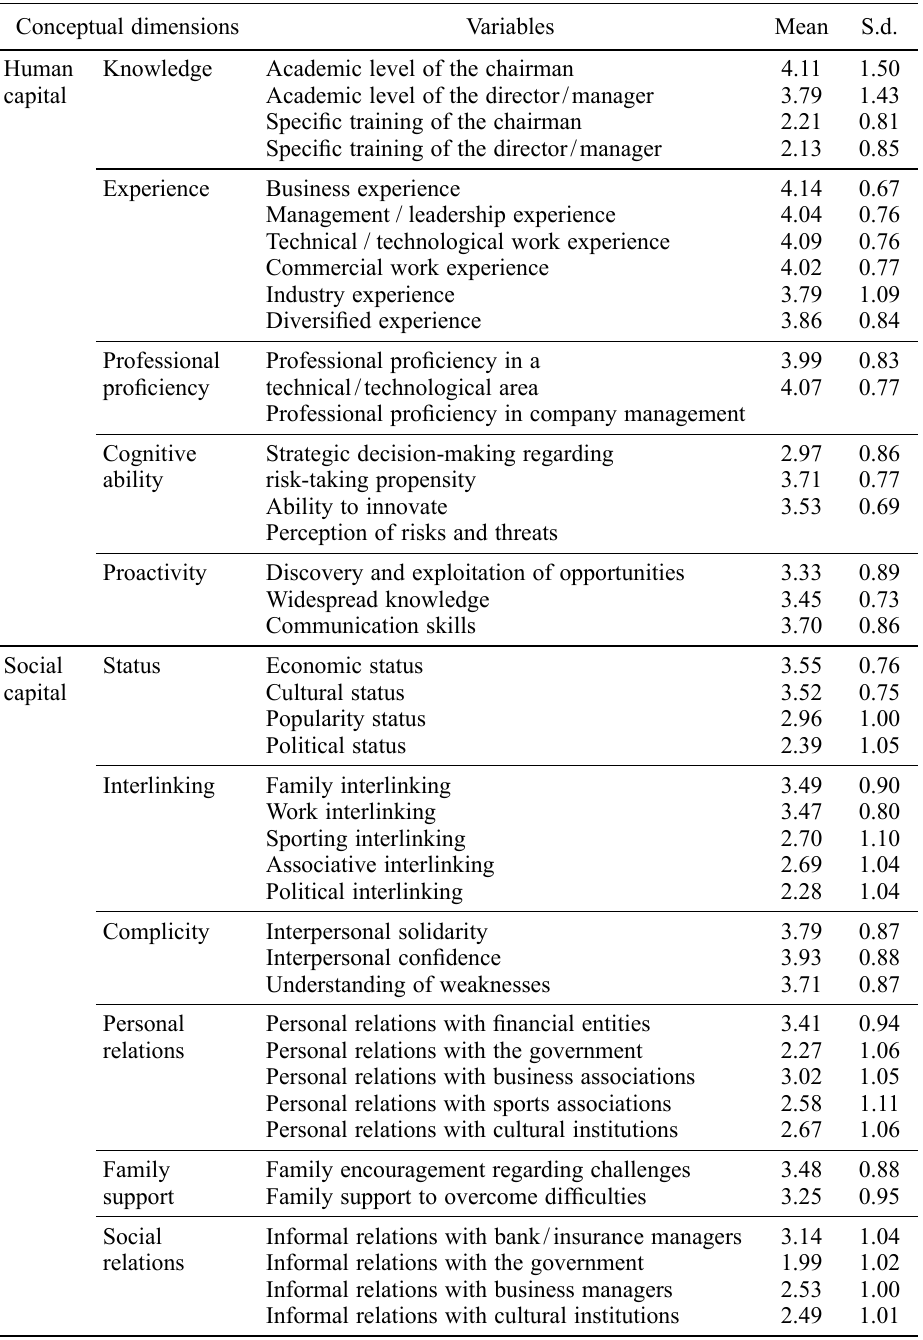
Table 1. Human capital and social capital survey items and descriptive statistics (mean and standard deviation) Conceptual dimensions Variables Mean